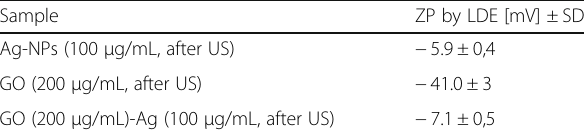
Table 3 Test results of zeta